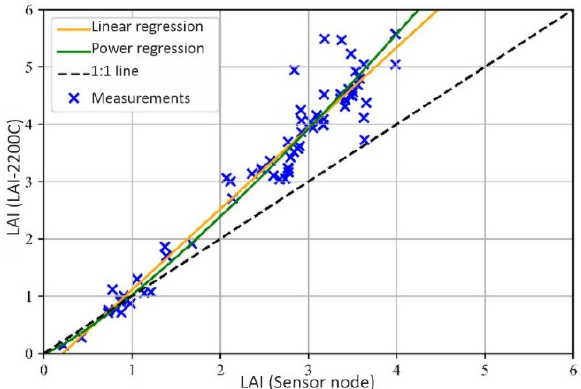
Figure 11. Relationship between the LAI that was measured with the LAI-2200C and with our sensor node in the field experiments. The plot also contains two optimized regression functions to fit the data: a linear and a power regression function.